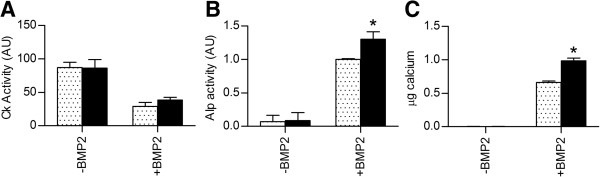
Effect of miR-378 overexpression on C2C12 differentiation. A-C) Creatine kinase (A) and Alp (B) activity in and calcium deposition (C) by C2C12-pMirn0 (light bars) and C2C12-pMirn378 (dark bars) cells after 6 (A-B) or 10 (C) days of culture in the presence or absence of 300 ng/ml BMP2. A) The mean values +/− SD of two biological replicates, whereby each measurement was made in duplicate, are shown. B) Mean values +/− SD of three independent experiments with biological duplicates each. For each independent experiment, Alp activity values were normalized to the average of the C2C12-pMirn0 samples treated with BMP2. C) Data shows calcium deposition in 24-well plates and is representative of 2 independent experiments. Mean values +/− SD of two biological replicates in one experiment, whereby each measurement was made in duplicate, are shown. *p < 0.05 when compared to the C2C12-pMirn0 sample with the same treatment. AU: arbitrary units.